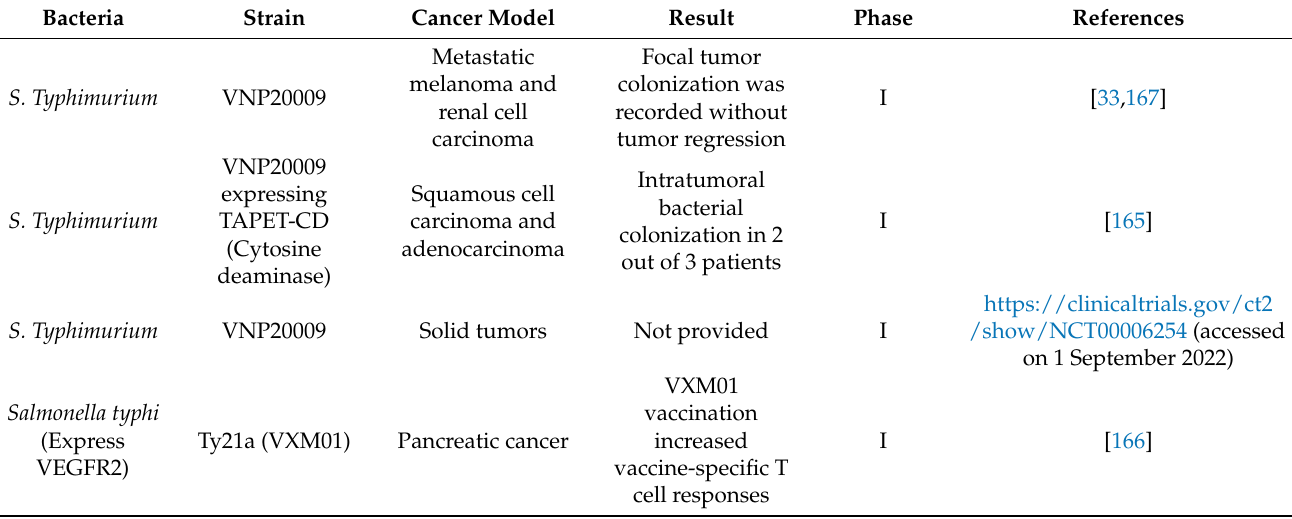
Table 2. List of Salmonella strains under human clinical trials for cancer